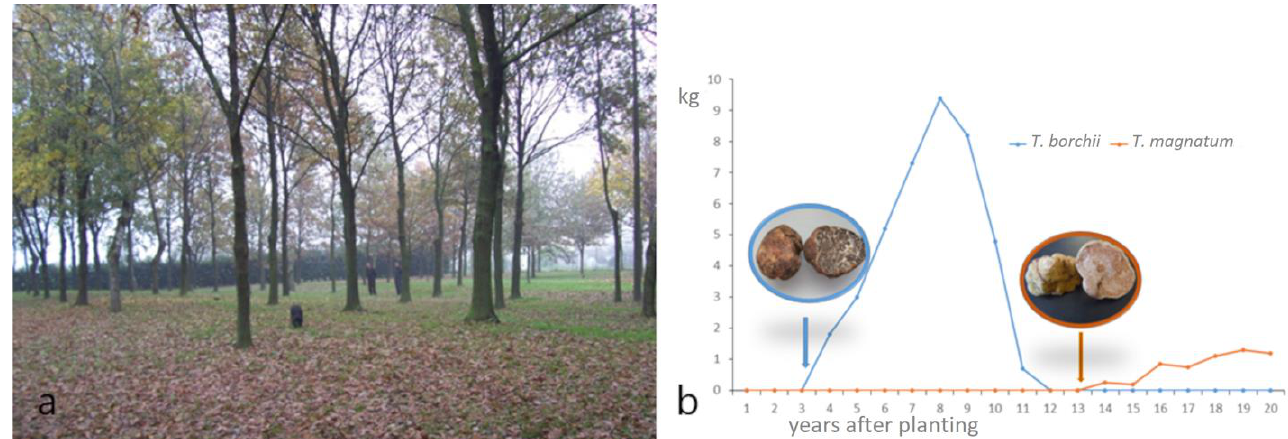
Figure 2. Old T. magnatum cultivation. ( a ) T. magnatum orchard of Q. robur mycorrhized plants; ( b ) ascocarp production trend during the first 20 years after plantation.